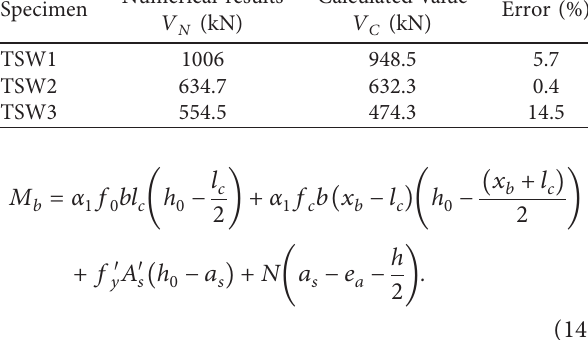
Table 5: Comparison of numerical simulation and calculation results. Numerical Specimen